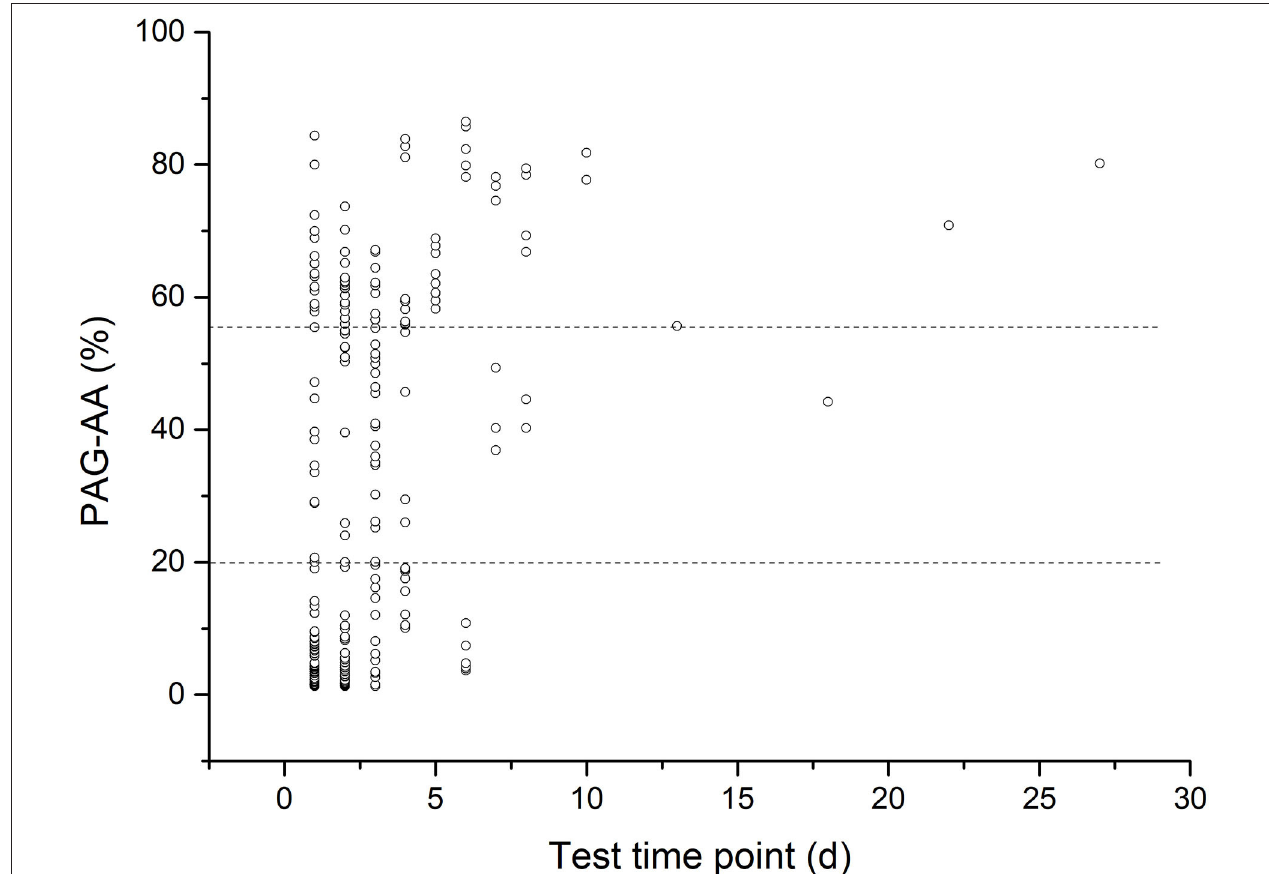
FIGURE 1 | The scatterplot of basal arachidonic acid- induced platelet aggregation (PAG-AA) distribution.